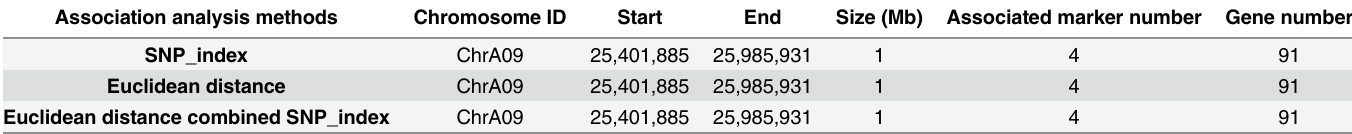
Table 6. Information on the association region by the SNP_index, Euclidean distance and Euclidean distance combined SNP index association analysis methods. Association analysis